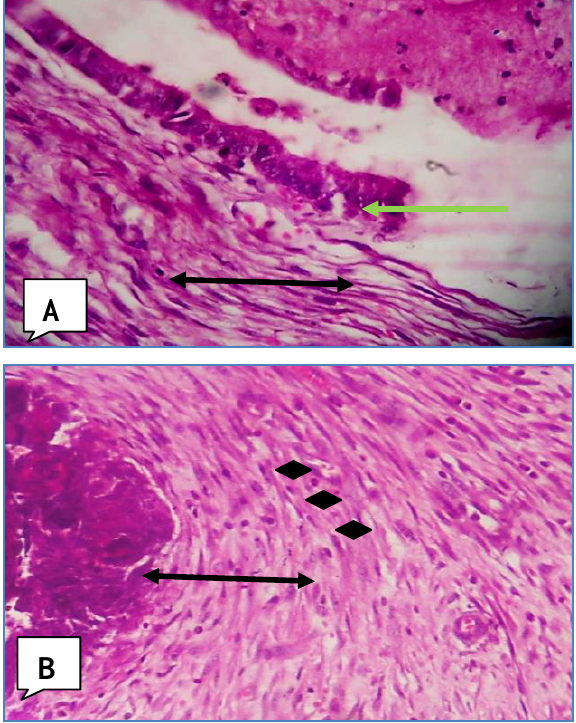
Figure, 3 (A-B): Show partial re-epithelialization of incision space by columnar epithelial , proliferation of collagen fibers and decrease in the number of the neutrophils, large amount of granulation tissue that replaced all sub-mucosa , together with slight hyperplasia of epithelial mucosa that accompanied with necrotic cells remnant extra mucosal pattern one week post operation (H and E